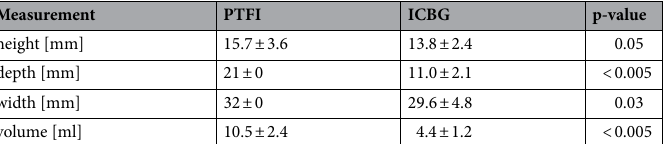
Table 5. Height, depth, width and volume of PTFIs and ICBGs (initial measurement). The measurements are presented as the means ± standard deviations.